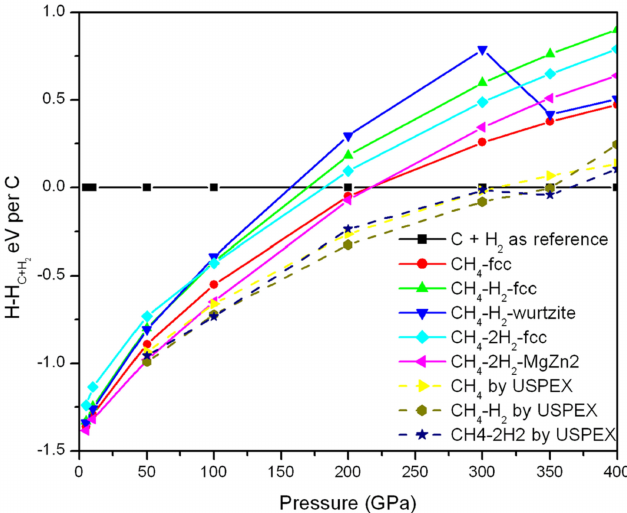
Figure 7. Computed enthalpy of wurtzite-type structures (with respect to carbon and H 2 ) as a function of